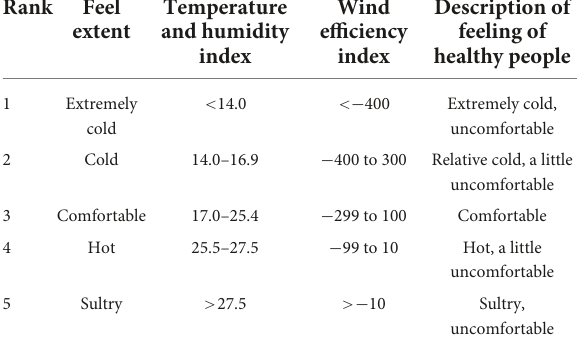
TABLE 3 Classification of climate comfort degree of human settlement